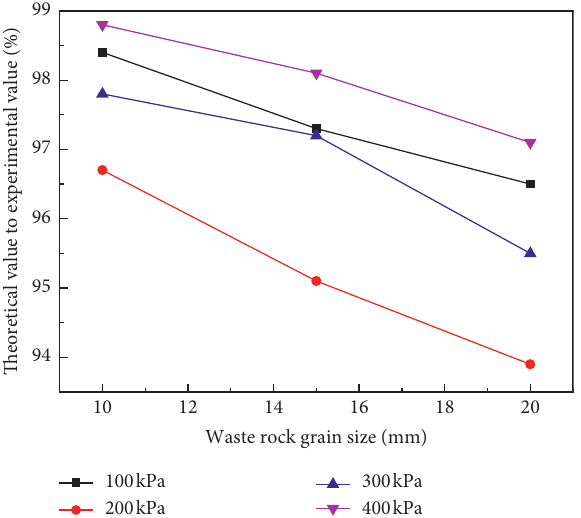
Figure 8: Relationship between waste rock grain size and the ratio of the theoretical value to experimental value of shear